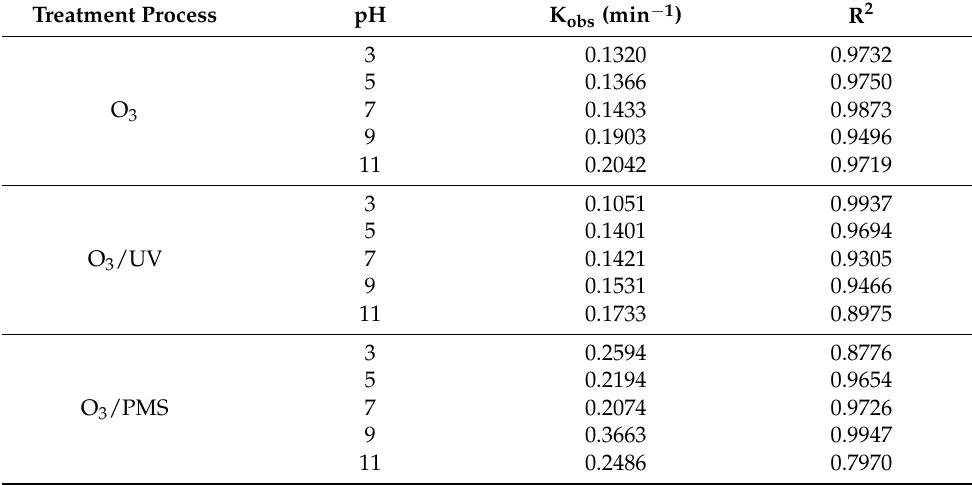
Table 6. Pseudo-first-order rate constants of O 3 , O 3 /UV, and O 3 /PMS processes at different pH (reaction conditions: pH = 3, 5, 7, 9, 11, SDZ = 10 mg/L, O 3 = 3 mg/L, T = 25 ± 0.5 ◦ C, O 3 = 3 mg/L, PMS = 22.8 mg/L, UV = 0.9 mw/cm 2